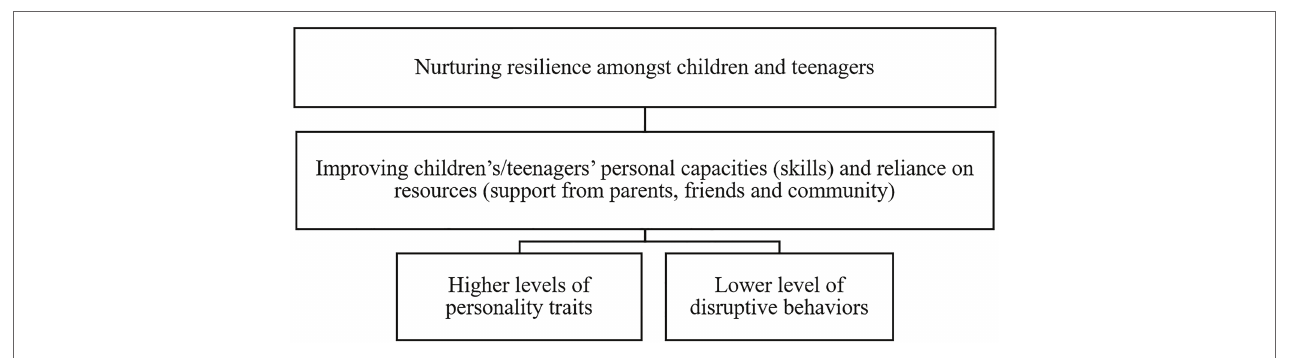
FIGURE 3 | Factors and process of resilience as predictors of parental internet